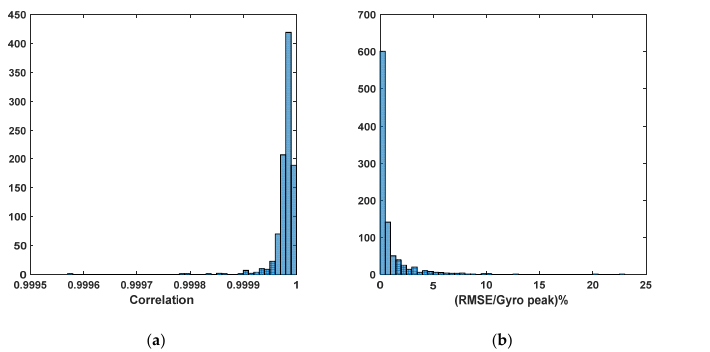
Figure 13. Correlation ( a ) and RMSE ( b ) between original and reconstructed gyro signal for each stride.